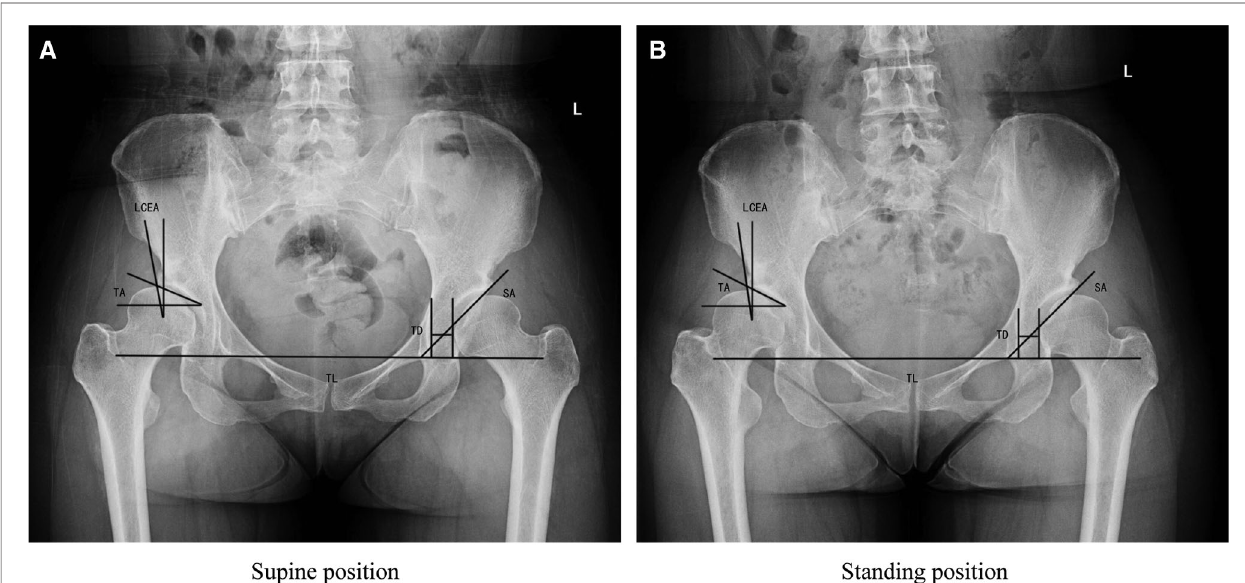
FIGURE 2 | Supine ( A ) and standing ( B ) AP pelvic radiograph are shown. TL is the teardrop line; LCEA and TA are the lateral center edge angle and Tönnis angle, TD and SA are the teardrop distance and sharp angle. TD in the standing position was larger than that in the supine position.